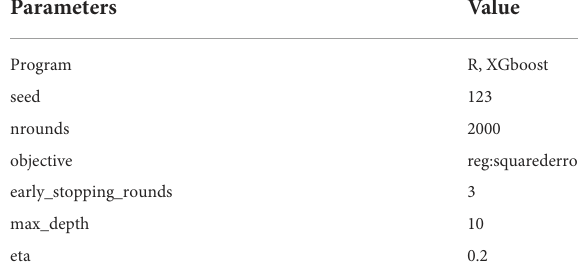
TABLE 10 Parameters used in the XGboost